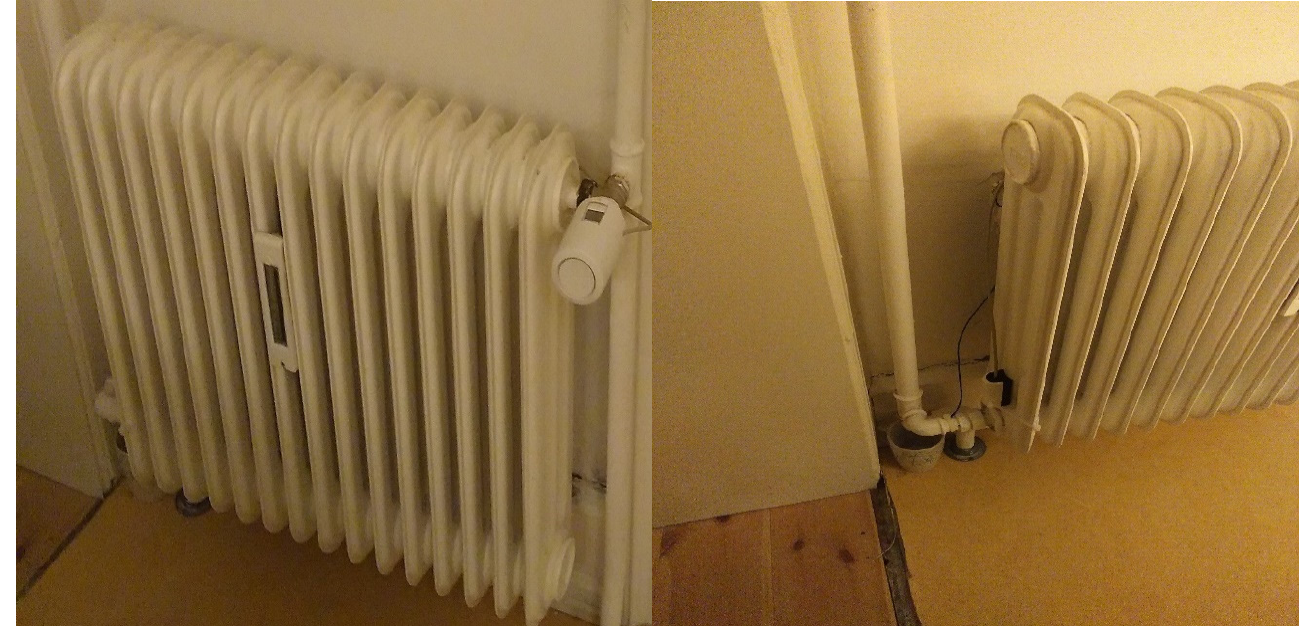
Figure 5. Pictures of the prototype thermostat and return temperature sensor and how they were installed on the supply ( left ) and on the side of the radiator ( right ) in the test buildings. Two different prototypes were developed and tested during the length of this project.